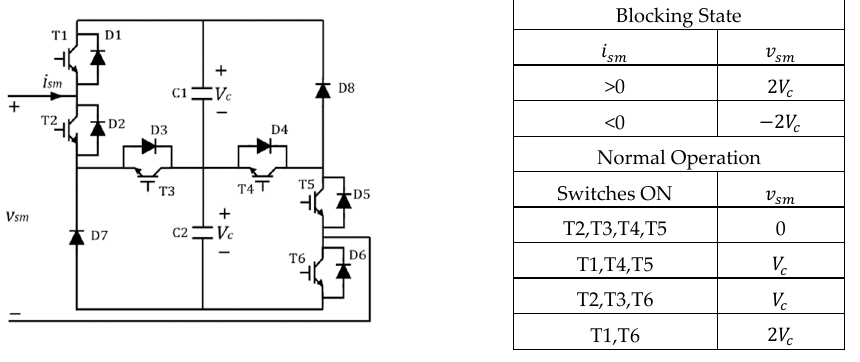
Figure 13. Figure 13. ACTSM.